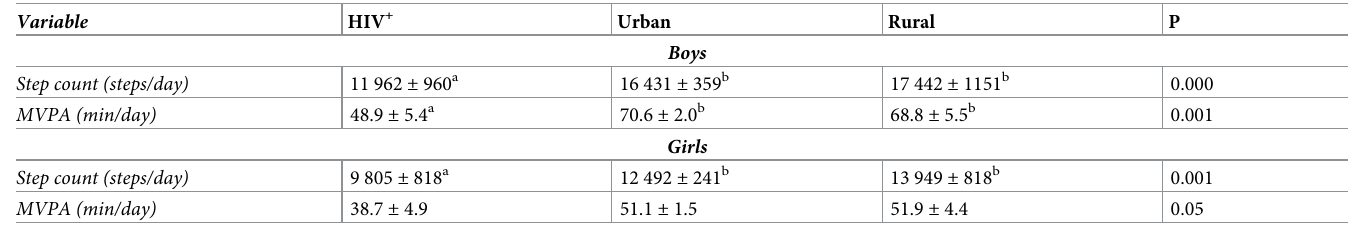
Table 5. Comparison (mean ± sd) of average number of steps per day and time spent in MVPA between HIV + and HIV negative urban and rural Mozambican boys and girls; p values were generated from the ANCOVA test with age as a covariate.